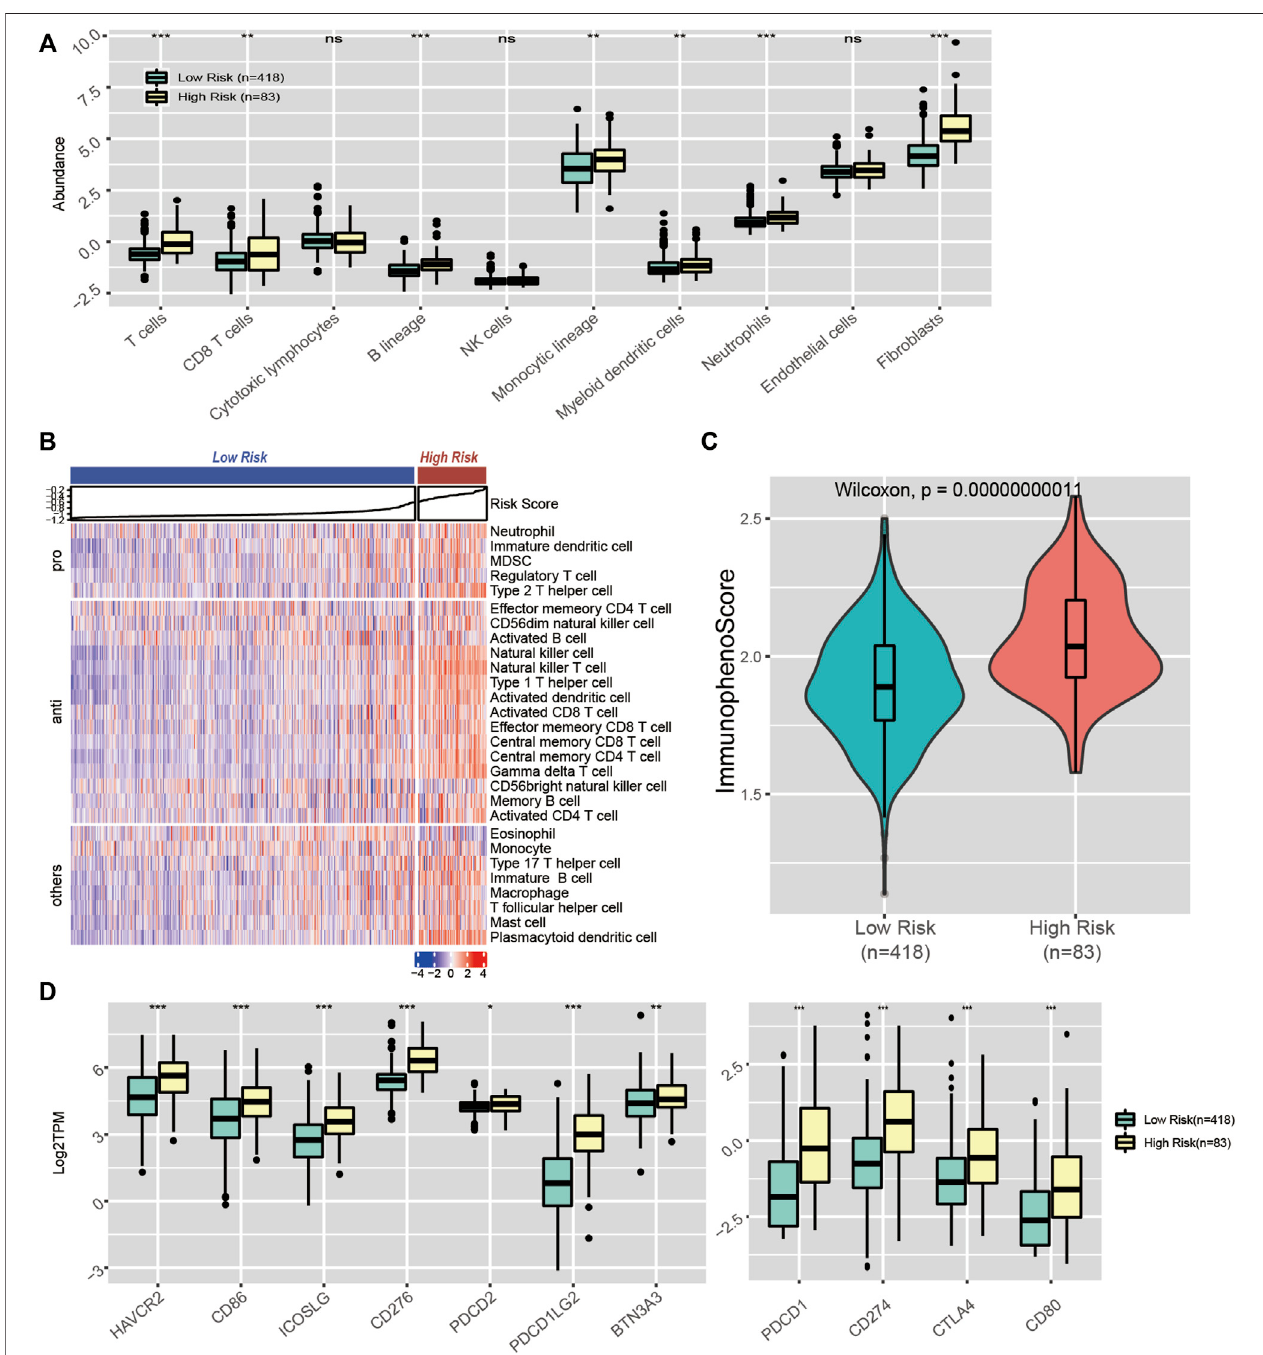
FIGURE 9 | Immune landscape in CpG signature-strati fi ed LGGs. (A) Boxplot of the abundance of 10 immune cell subsets estimated by MCP-counter. (B) Heatmap of the enrichment scores of 28 immune cell subsets generated by ssGSEA. (C) Violin plot showing the distribution of immunophenoscores in the low-risk and high-risk groups. (D) Expression levels of 11 immune checkpoint genes in the low-risk and high-risk groups.